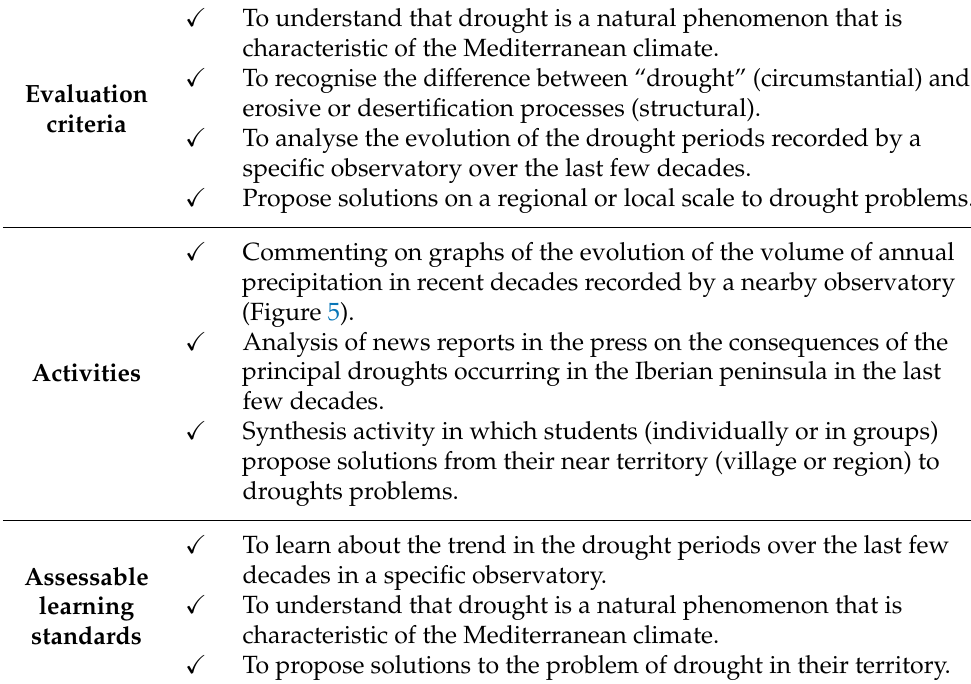
Table 4. Activities proposed for teaching about drought on the Mediterranean coast (1st and 3rd, Secondary Education).